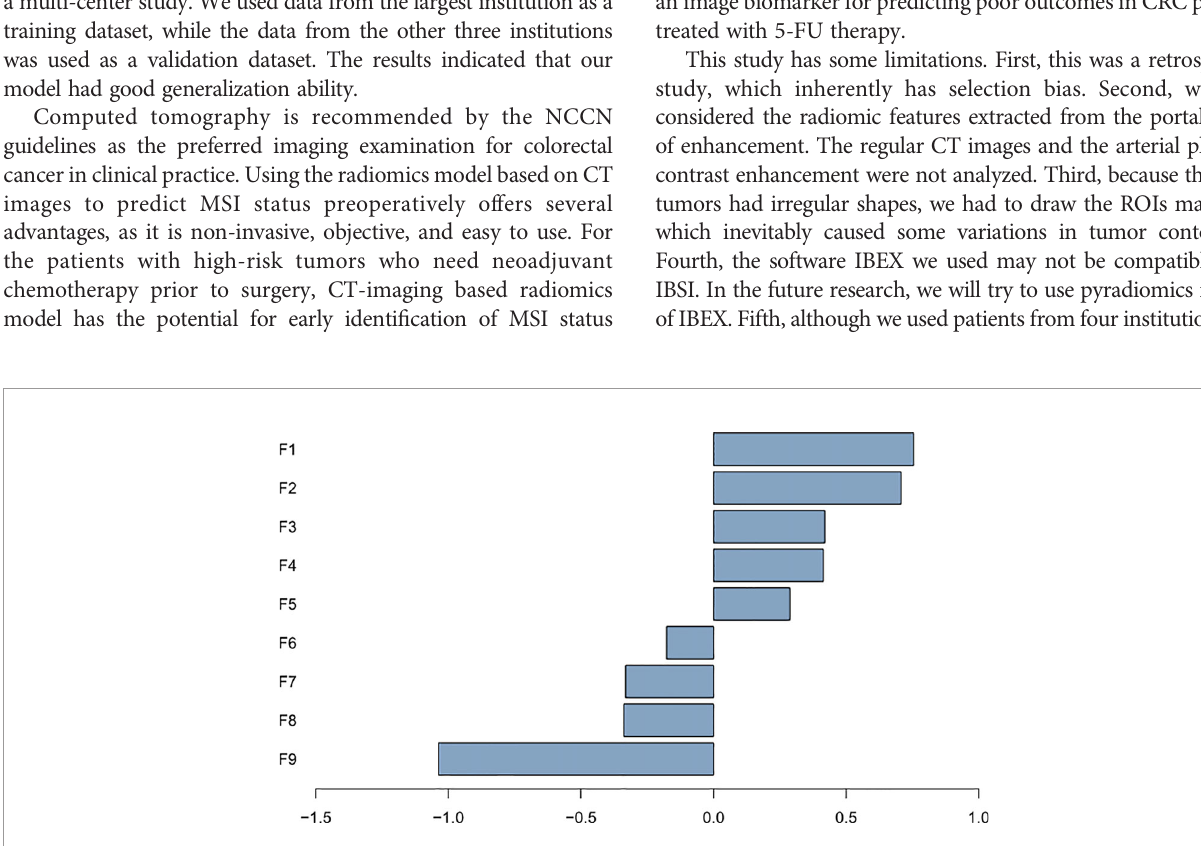
FIGURE 5 | Plot of regression coef fi cients for features F1: energy; F2: location; F3: correlation; F4: coarseness; F5: gray level nonuniformity; F6: dissimilarity; F7: compactness; F8: cluster tendendcy; F9: number of